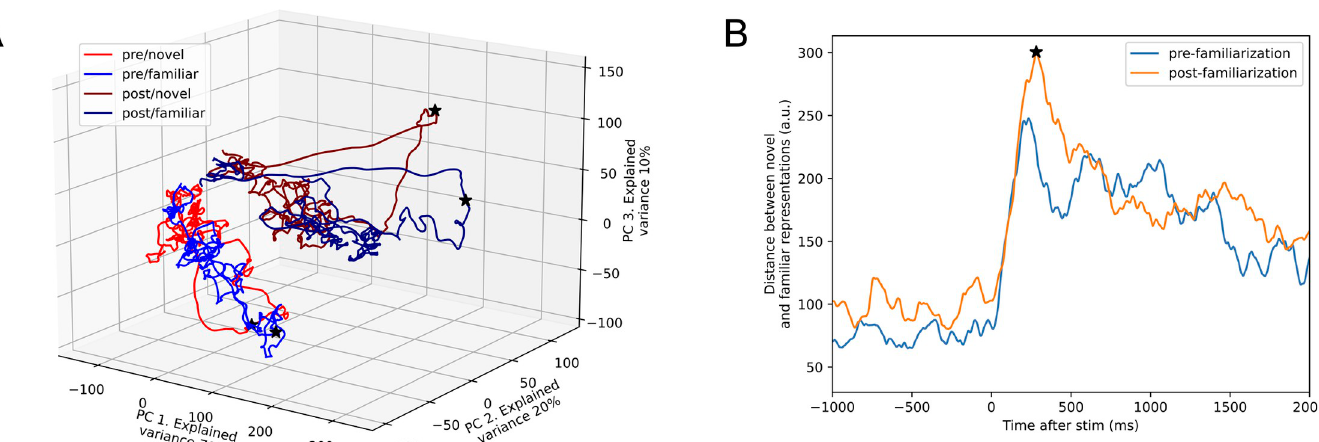
Fig 4. Familiar-odor-biased PNs and LNs are novelty and familiarity detectors. PNs and LNs display initial response biases to the two test odors Hex and Oct prior to familiarization ( A1, A2 ). Some neurons respond more strongly to Oct than to Hex, i.e., data points above the diagonal line; some neurons respond more strongly to Hex than to Oct, i.e., data points below the diagonal line. Additionally, PNs are generally more responsive than LNs, evident from the wider distribution of data points along both X and Y axis. The Oct-biased units are above the diagonal line and the Hex-biased units are below the diagonal line. Then they are familiarized with Oct or Hex. Only the familiar- odor biased neurons showed consistent familiarity and novelty effects. In familiar-odor biased PNs ( B1 ), whether it is Hex-familiarized or Oct-familiarized, most of the neurons decreased their responses to the familiar odor after the familiarization process, as revealed by the negative median values in the box plots (1st and 3rd boxes). In contrast, most of the neurons increased their responses to novel odor after the familiarization process–namely novelty effect, as shown by the positive median values in the box plots (2nd and 4th box). The familiarity and novelty effects are also evident in the familiar-odor biased LNs ( B2 ). In Hex-familiarized familiar-odor biased PNs, 63% (n = 14) of the neurons exhibited the familiarity effect and 69% (n = 15) of the neurons exhibited the novelty effect; this distribution pattern is significantly different from random process (p = 0.02, McNemar test) (purple boxes, C1 ). In Oct-familiarized familiar-odor biased PNs, also seen were significantly higher percentage of neurons adapted by familiar odor (56%, n = 18) and potentiated by novel odor (69%, n = 22) (blue boxes, C1 , p = 0.04, McNemar test). Similar phenomena were also observed among the familiar-odor biased LNs ( C2 ). In novel-odor biased PNs and LNs, the familiar and novel odors did not produce contrasting changes after the familiarization process; none of the comparing pairs showed significant familiarity and novelty effects ( D1, D2 , McNemar test).